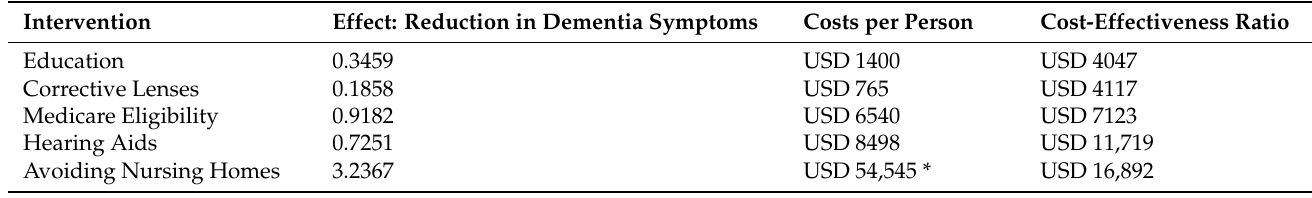
Table 1. Cost-Effectiveness of Various Dementia